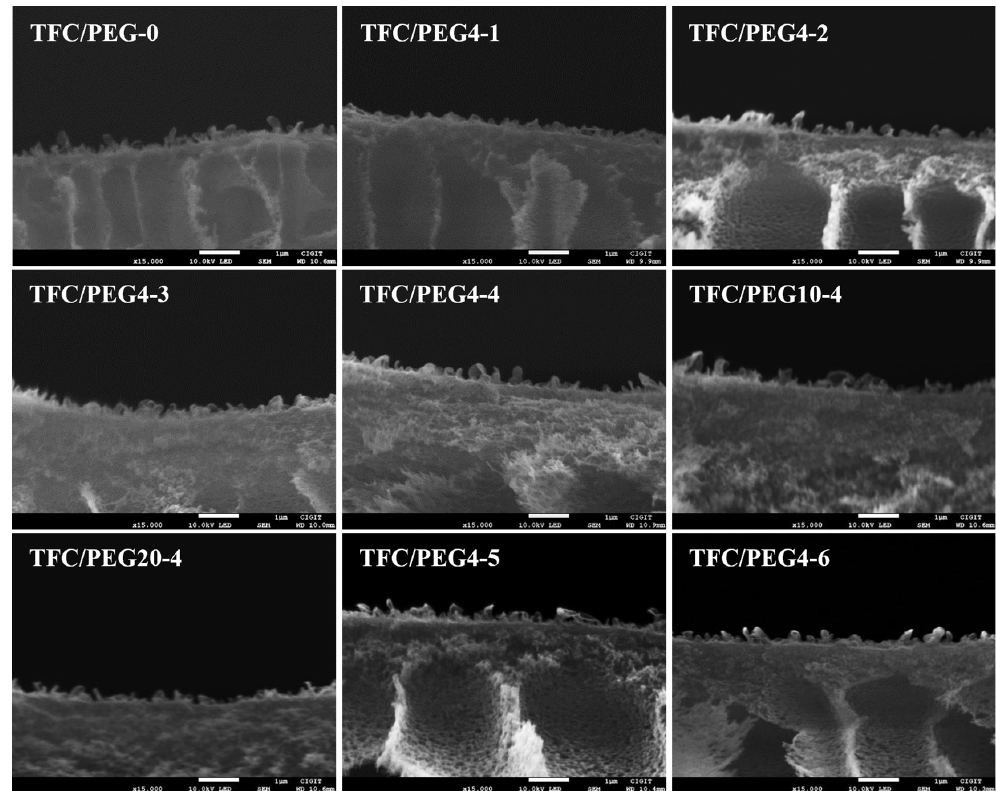
Figure 8. SEM images for cross-section of PSU/PEG supported TFC-FO membranes.